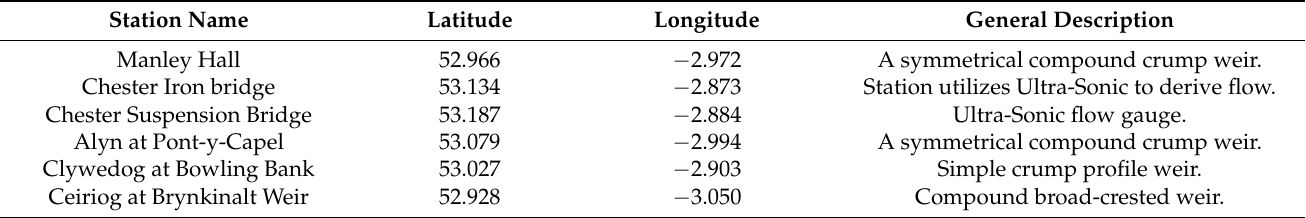
Table 2. River gauge stations utilized in the calibration and validation of the hydrological